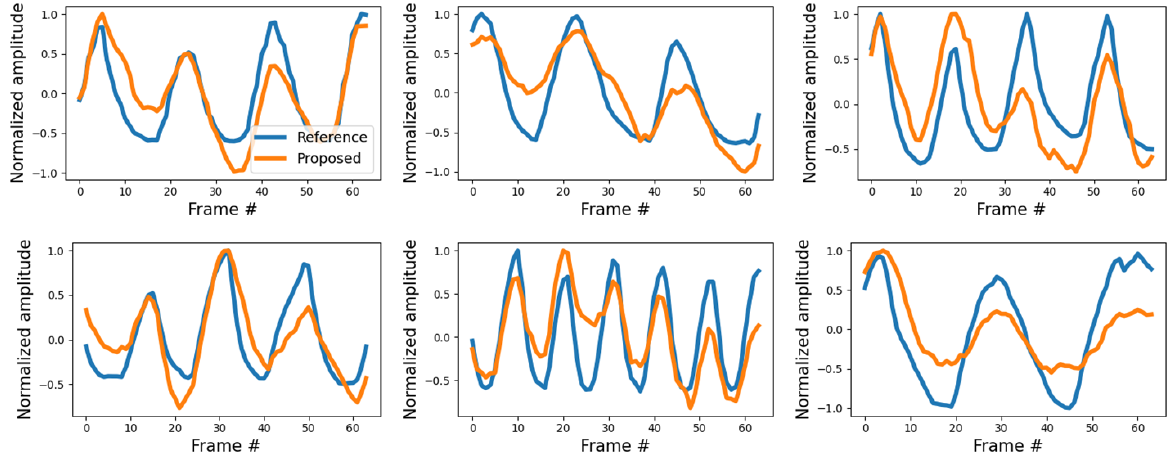
Figure 10. Examples of bpm estimation results and peak detection results in Experiments 1 and 3: ( a ) change in bpm measurement; ( b ) examples of peaks detected in the actual signal.